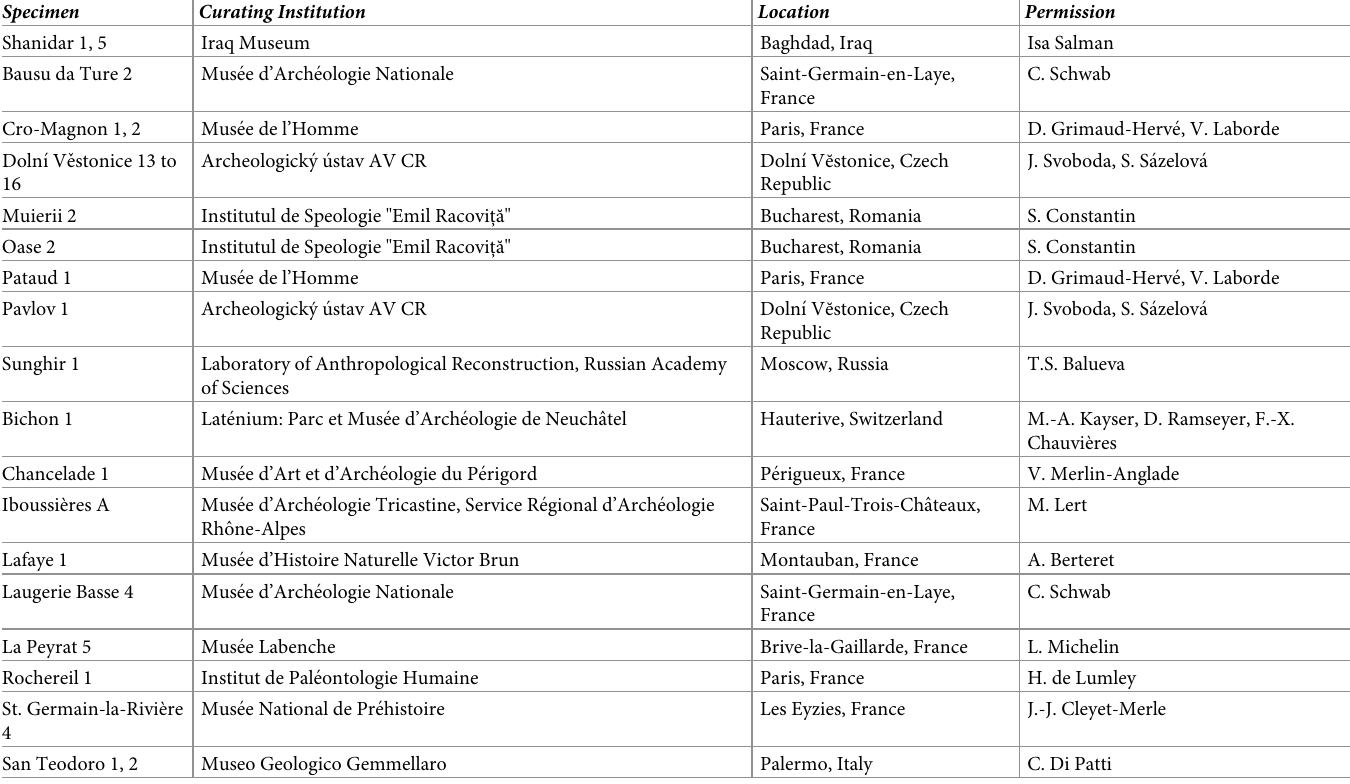
Table 1. Locations of original fossil human specimens observed by us for the scoring of external auditory exostoses. Specimen